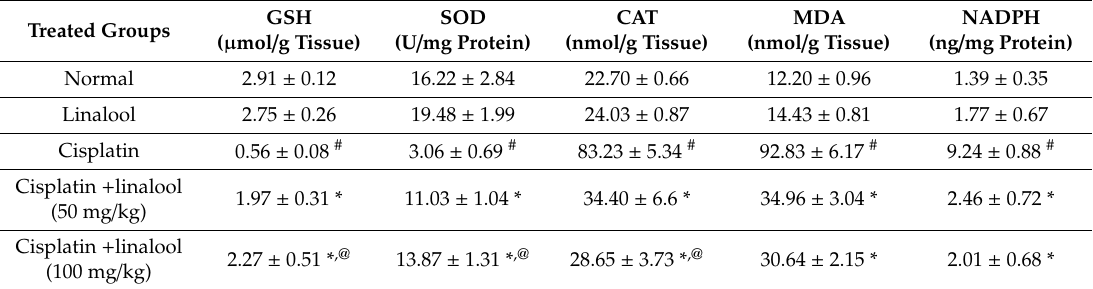
Table 3. E ff ects of linalool and cisplatin on the markers of oxidative stress in kidney tissues of rats. Treated